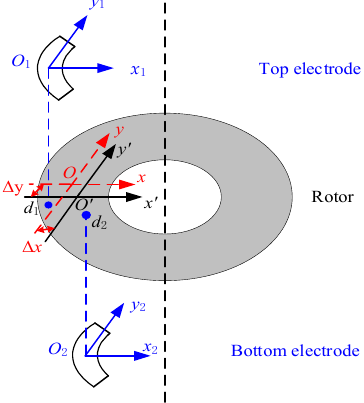
Figure 6. Alignment error caused by thermal expansion of the rotor .